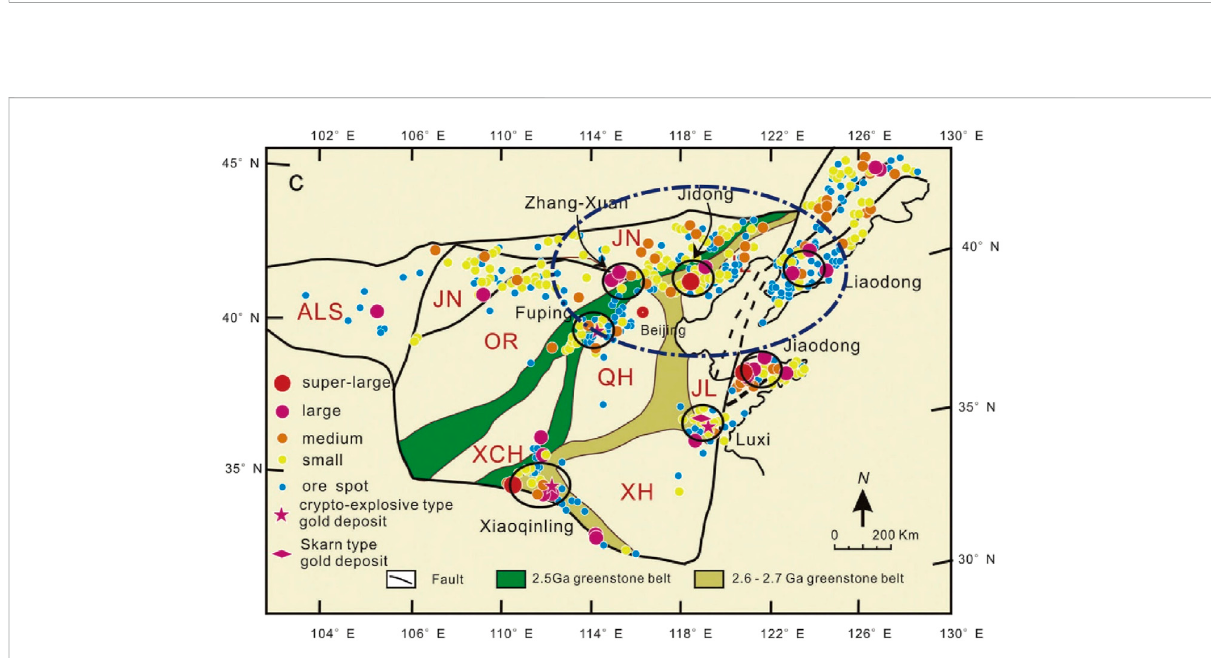
FIGURE 6 Circle: site of gold mineralization. The gold mineral distribution (Li et al., 2017) corresponds to the location of magmatic underplating and the upwelling mantle plume (blue